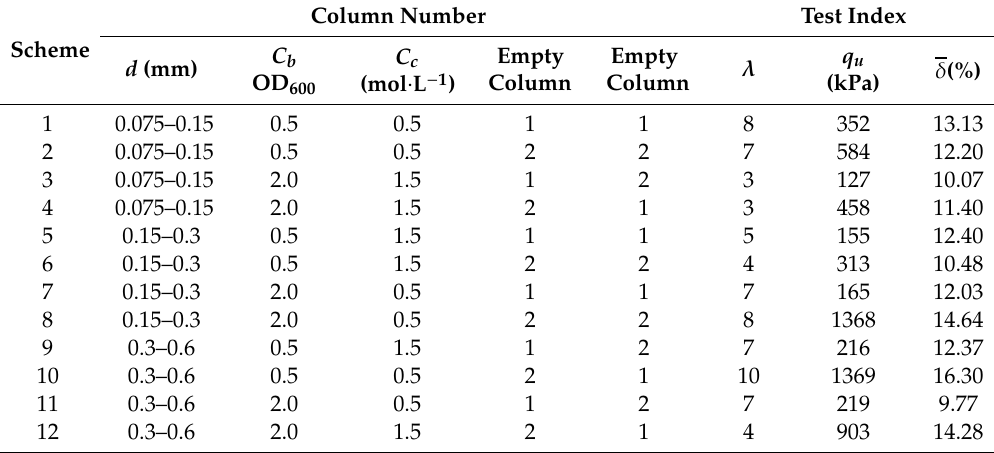
Table 3. L 12 (3 × 2 4 ) mixed horizontal orthogonal test